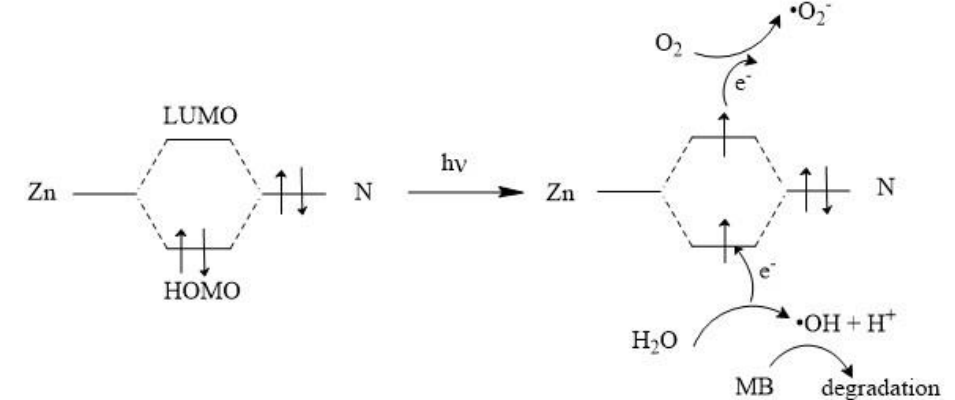
Fig. 12. A simplified model of the photocatalytic reaction mechanism of MB on Fe-ZIF-8.